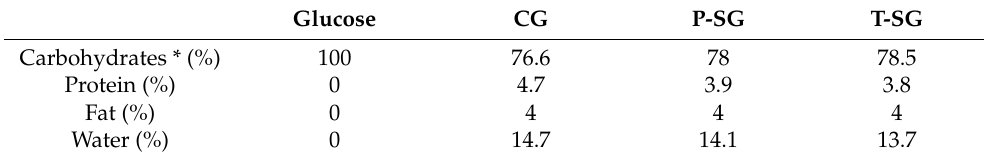
Table 5. Macronutrient composition of each gummy